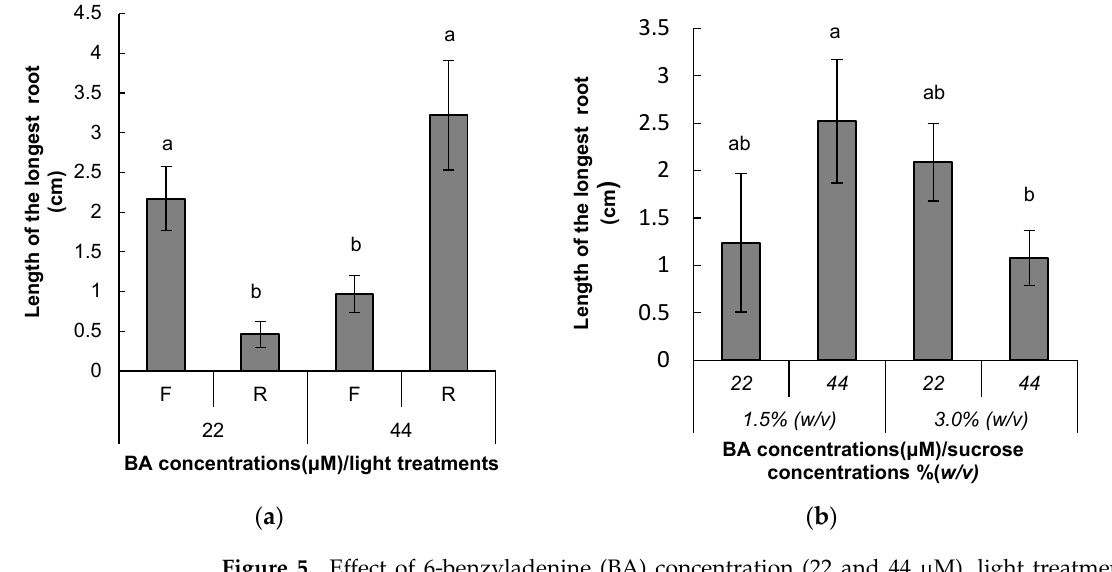
Figure 5. Effect of 6-benzyladenine (BA) concentration (22 and 44 μ M), light treatment (white fluorescent (F) and red LEDs (R)) ( a ) and BA concentration (22 and 44 µ M) and sucrose concentration (1.5% and 3.0% ( w / v ) ( b ) on length of the longest root (cm) of Pinus radiata D. Don shoots cultured in Quoirin and Lepoivre (LP) medium [27] modified according to Aitken-Christie et al. [28]. Data are presented as mean values ± S.E. Different letters indicate significant differences by Duncan’s post hoc test ( p < 0.05).